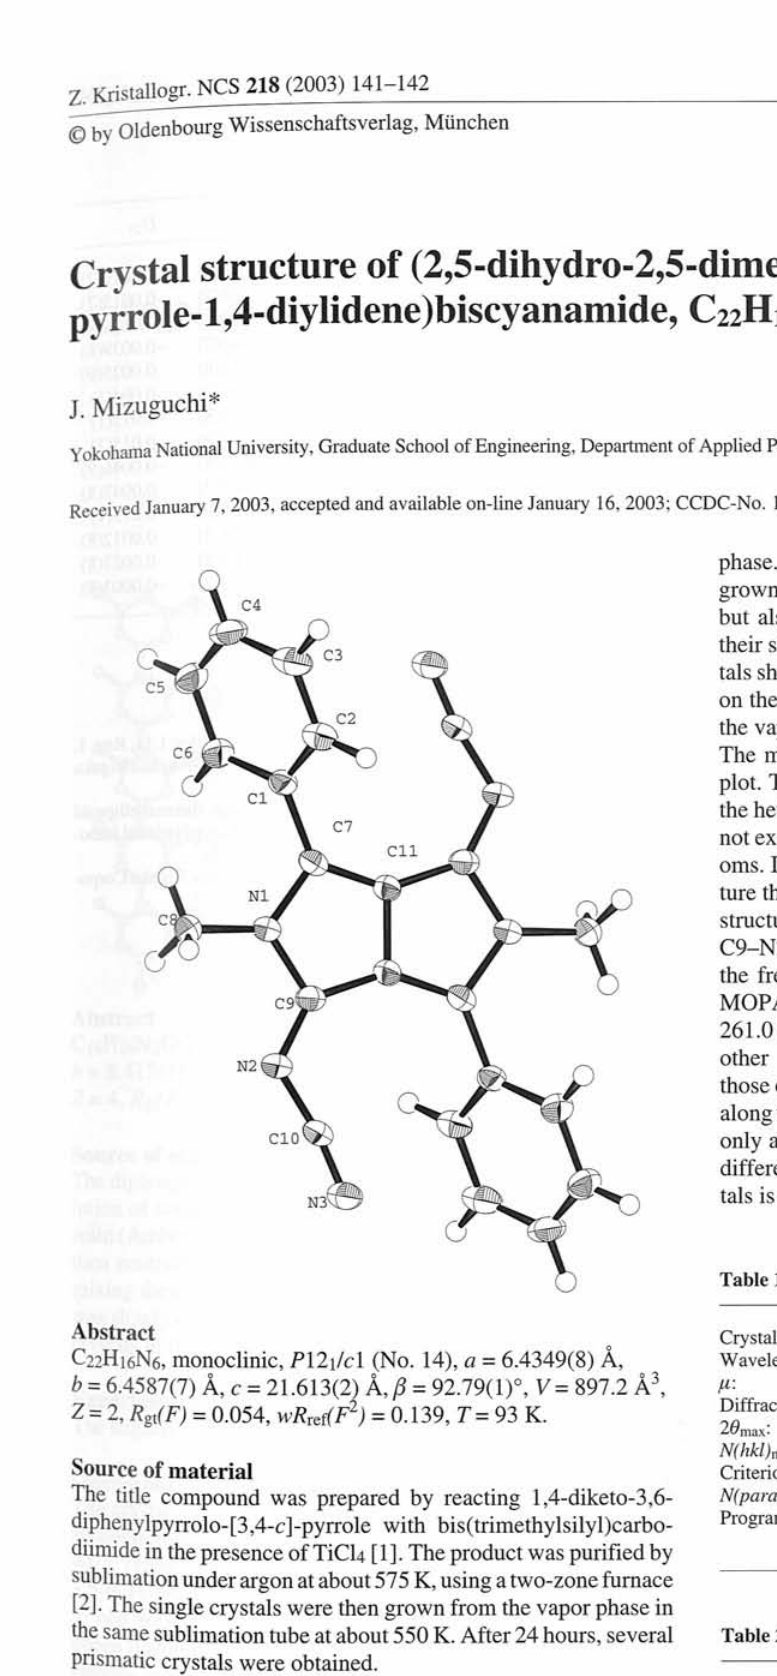
Table 2. Atomic coordinates and displacement parameters (in A